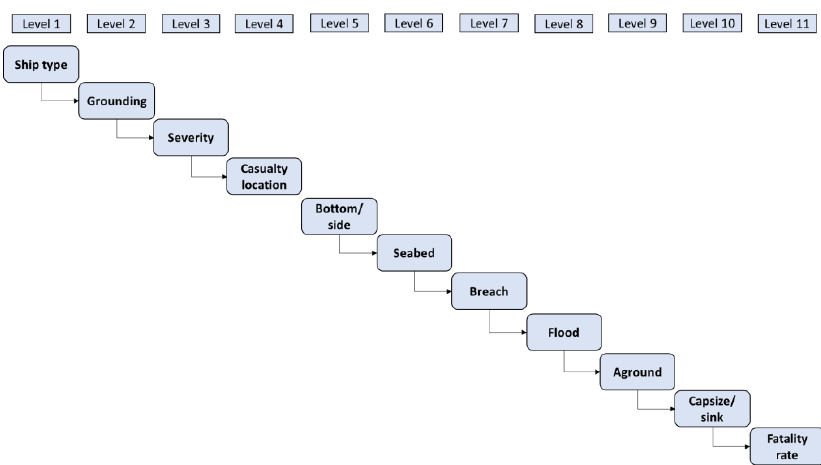
Figure 12. High-level event sequences in the current FLARE grounding risk model.